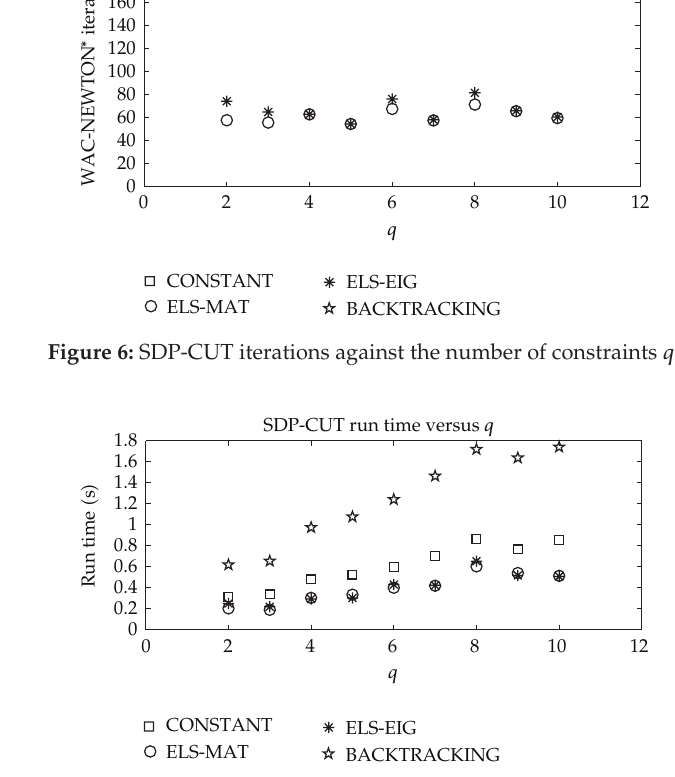
Figure 7: Time as it varies with the number of constraints q